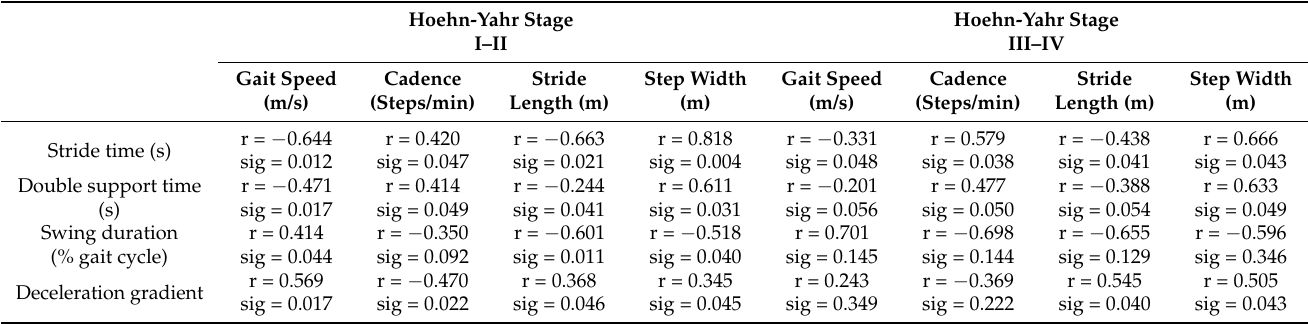
Correlation analysis by stage (Table 3) for the kinetic variables revealed that the greatest number of variables with significant correlations were recorded for stage I–II patients. More specifically, the walking cycle duration variable was the variable showing the highest correlation with the other variables analyzed. Table 3. Correlations between spatial-temporal parameters depending on the stage of the